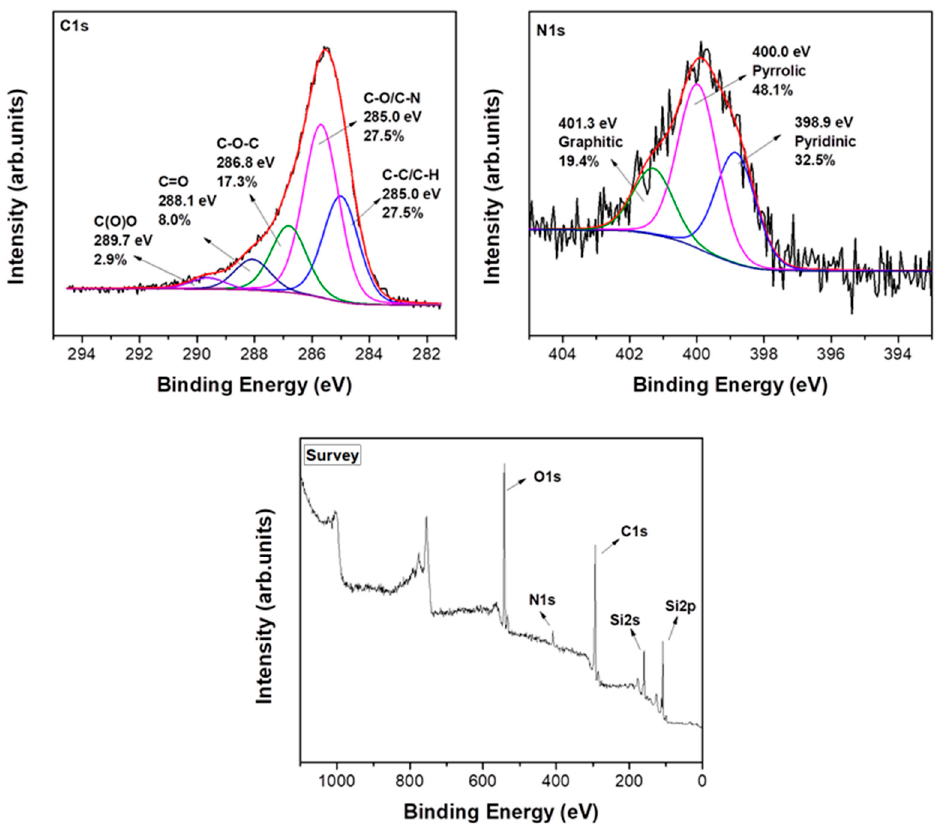
Figure 5. C1sphotoelectronspectrum( left ), N1sphotoelectronspectrum( right ), andX-rayphotoelectron Nanomaterials 2020 , 10 , x FOR PEER REVIEW Figure 5. C1s photoelectron spectrum ( left ), N1s photoelectron spectrum ( right ), and X-ray spectroscopy (XPS) ( bottom ) survey of C-GLOVE. photoelectron spectroscopy (XPS) ( bottom ) survey of C-GLOVE.